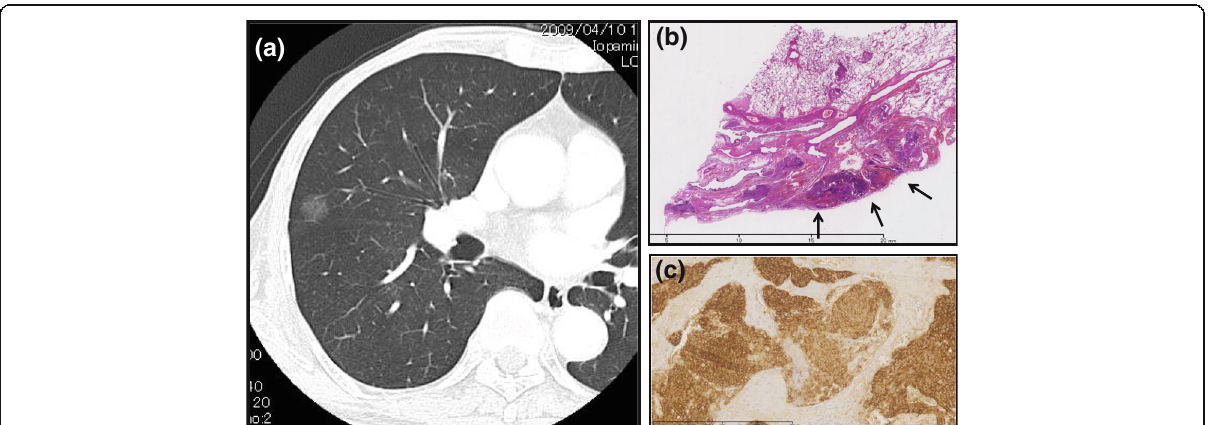
Fig. 1 a High-resolution computed tomography of the pure ground-glass nodule. Focal p-GGO was identified in the right middle lobe of the lung. b Hematoxylin staining of the resected specimen. Small round to spindle-shaped cells arranged in a spindle cell pattern with finely granular chromatin, inconspicuous nucleoli, and a scant to moderate amount of eosinophilic cytoplasm were seen in the form of many scattered tumor foci ( arrowheads ). c Immunohistological staining showed the tumor cells are positive for synaptophysin